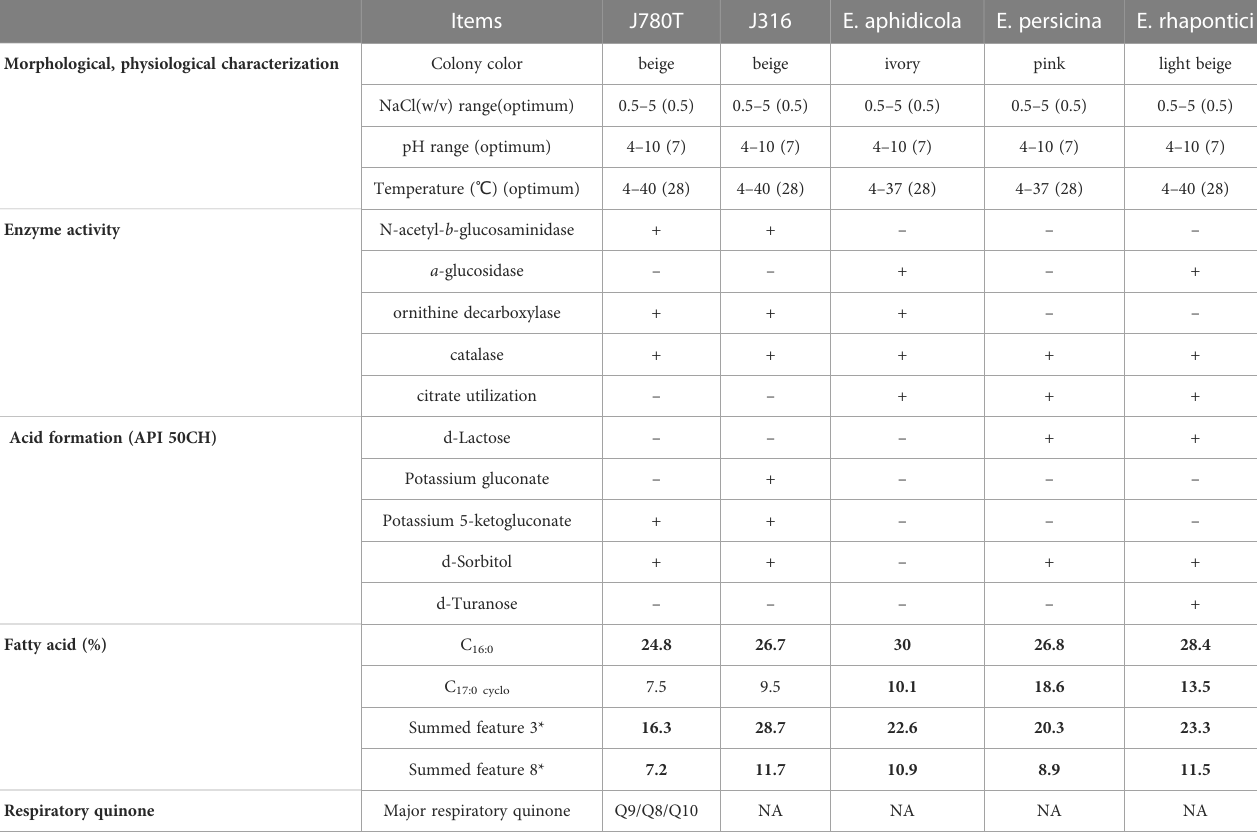
TABLE 1 Phenotypic characteristics, cellular fatty acid composition (percentages), and respiratory quinone differentiate Erwinia sorbitola sp. nov. and other species from Erwinia. All data was taken from this study unless otherwise indicated. +, Positive; -, Negative; NA, not